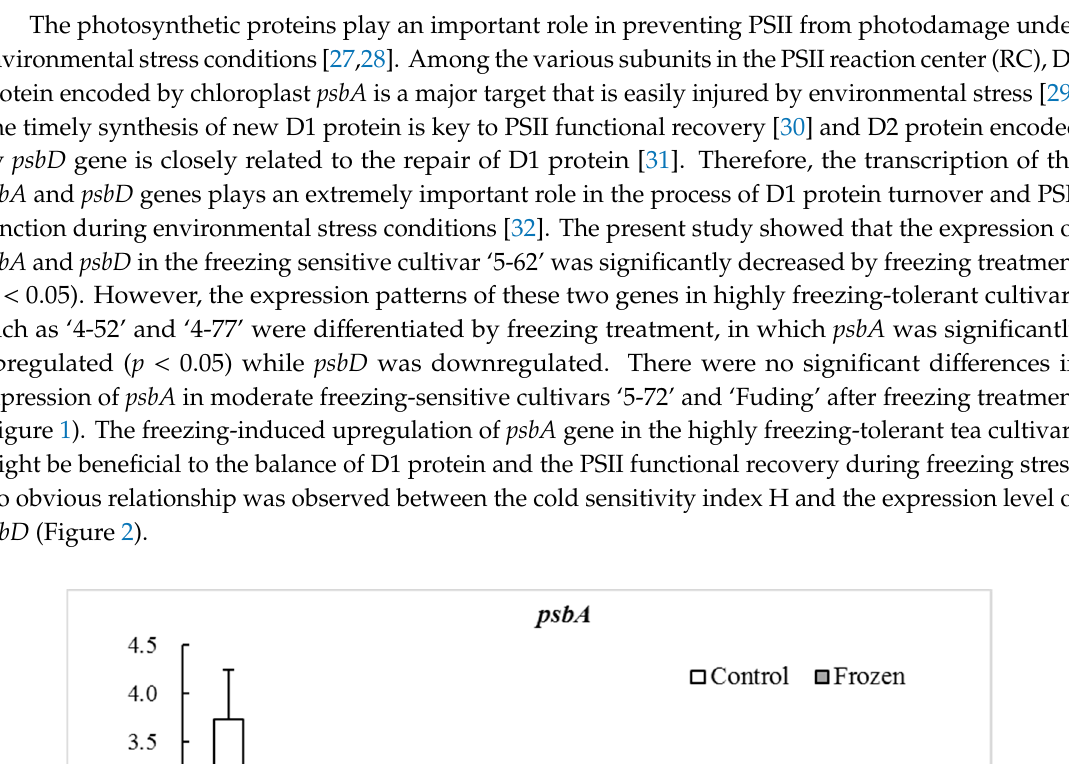
Figure 2. Effect of freezing on the expression of gene psbD . When calculating the relative expression values, the tested data were firstly normalized using β - actin as an internal reference, and then made relative to the control of ‘4-52’ in which the expression value of ‘4-52’ control was fixed as 1.0. 2.4. Effects of Freezing on Leaf Color of Various Tea Cultivars When values on Hunter color scales were used as color indicators, it was showed that the light- dark scale L value and green-red scale a value were significantly increased, whereas the blue-yellow scale b value significantly decreased after freezing treatment (Table 3). The L is a white-black indicator,